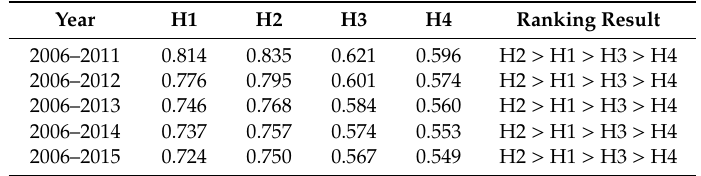
Table 2. Grey comprehensive relevance degree of sustainable development level and spatial structure in di ff erent periods of the Jiangsu Economic Belt. Year H1 H2 H3